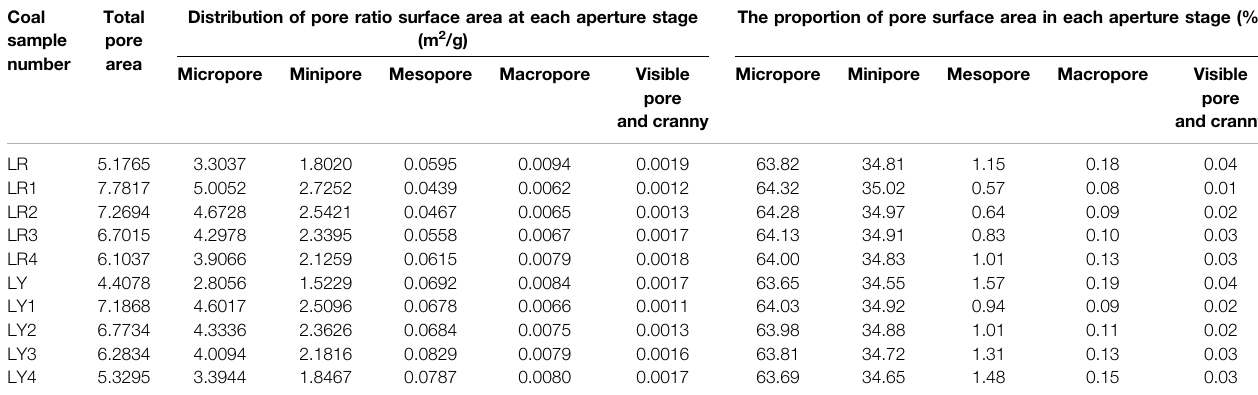
TABLE 4 | Pore area distribution of coal samples with the mercury intrusion